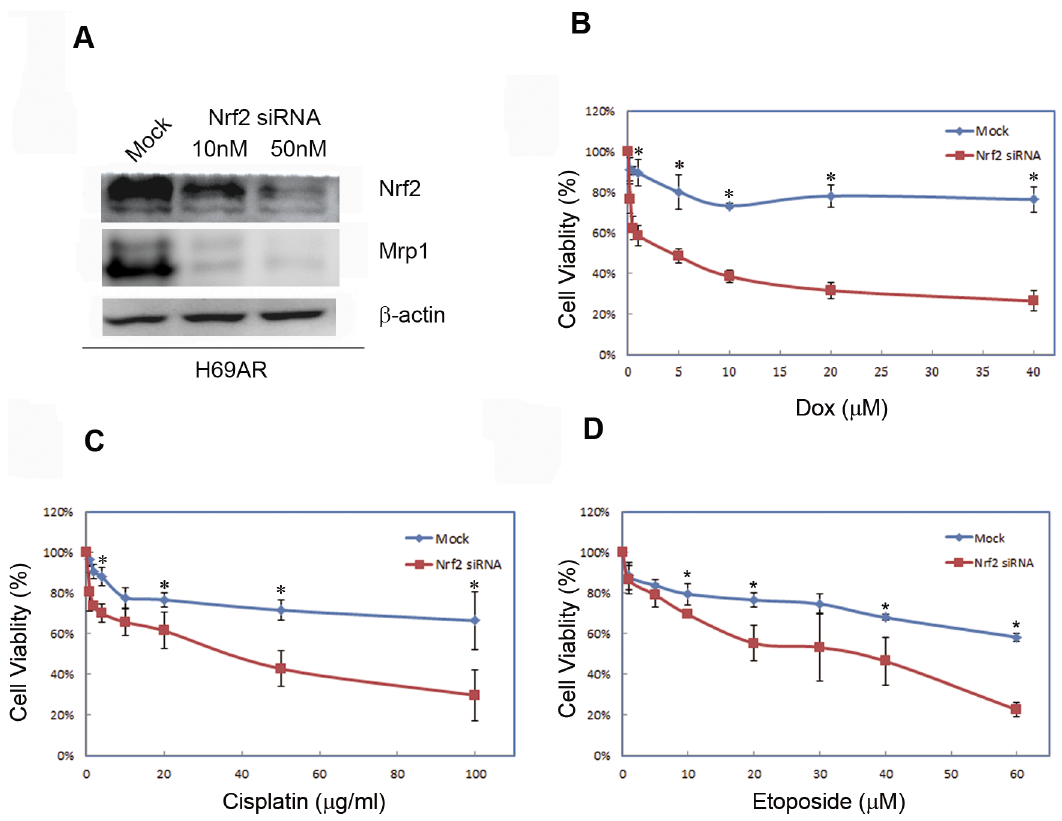
Figure 2. Down regulation of Nrf2 leads to decreased Mrp1 and sensitized H69AR cells to chemotherapeutic drugs. (A) H69AR cells were performed transfection of Nrf2 siRNA (10 nM and 50 nM) for 72 hours. Protein expression of Nrf2 and Mrp1 was determined by western blotting using b -actin as internal control. Experiments were performed three times and a representative immunoblot was shown here. (B), (C) and (D) H69AR cells were subjected to knockdown of Nrf2 with siRNA transfection. Forty-eight hours later, cells were treated with Dox, Cisplatin and Etoposide in different doses for additional 24 hours, and they were then subjected to MTT assay to measure cell viability. The experimental differences were determined by two-tailed Student’s t-test and p , 0.05 was taken as a significant difference in all cases.